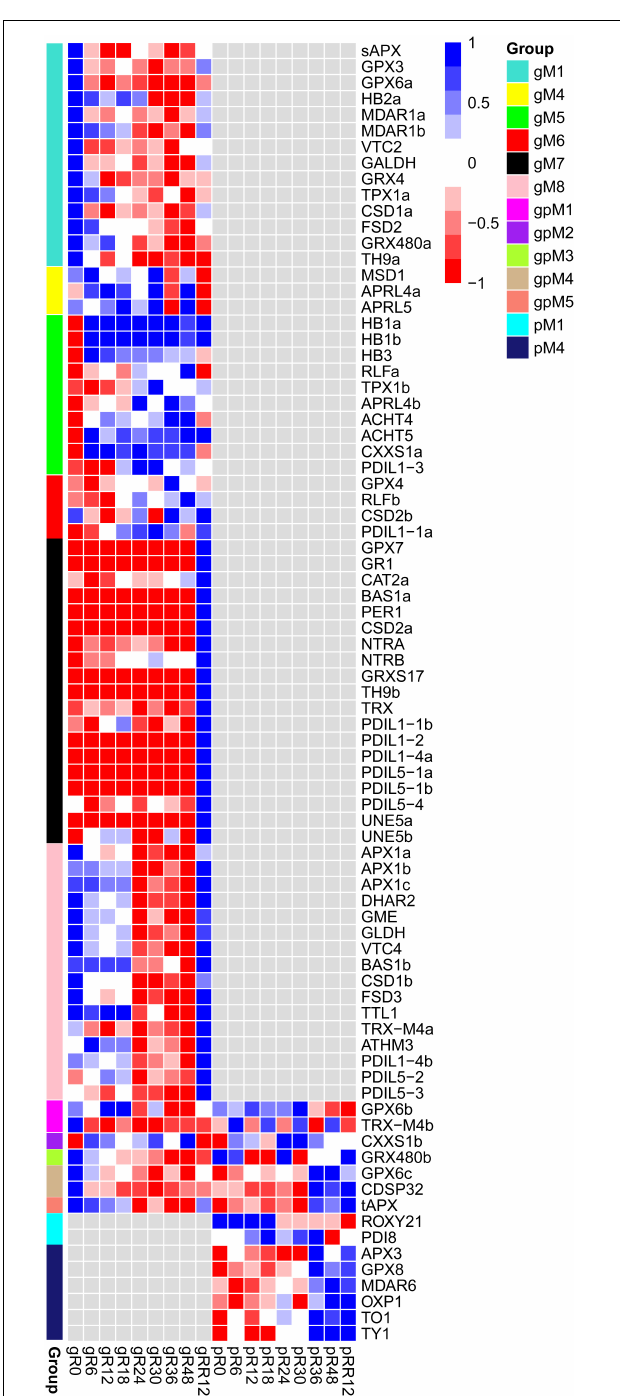
FIGURE 5 | Expression profiles of DEGs and DEPs involved in redox metabolism during flooding stress. Each row represents a gene with its name at the right.